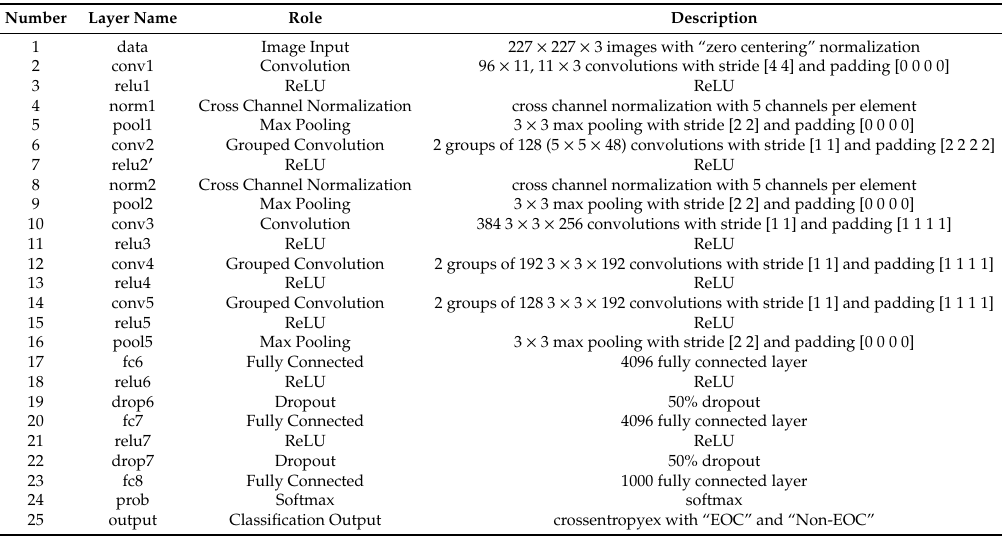
Table 1. AlexNet